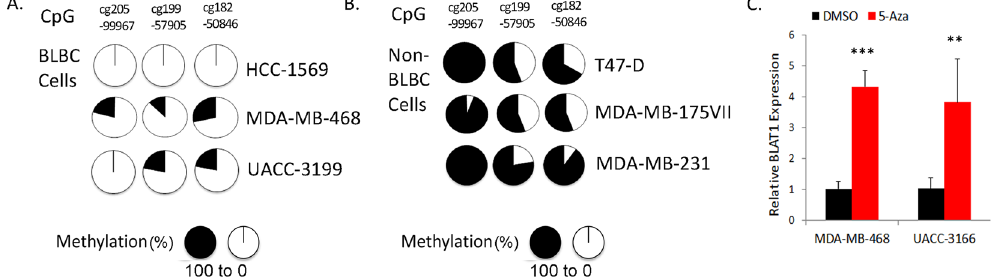
Figure 6. Bisulfite sequencing of the BLAT1 promoter in BLBC cell lines. ( A , B ) Bisulfite sequencing of three CpG sites (cg20599967, cg19957905, and cg18250846) showed a lower percentage of methylation in basal-like breast cancer (BLBC) cell lines, compared to the non-BLBC cell lines. ( C ) Inhibition of methylation with 5-Aza- 2 ′ -deoxyctidine (5 ′ -Aza) led to a significant increase in BLAT1 expression in MDA-MB-468 and UACC-3199